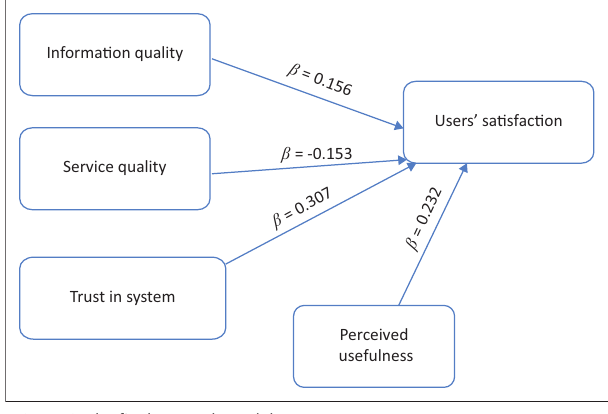
FIGURE 6: The final research model.